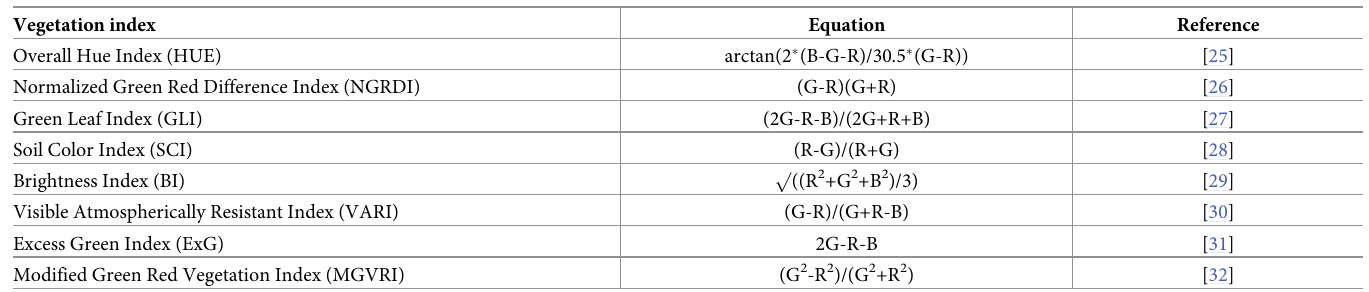
Linear regression models were fit using the percentage split option, where 90% of the dataset was considered for model training. The accuracy of fitted models was checked by the root mean squared error (RMSE) (Eq 1), and the normalized RMSE (NRMSE) (Eq 2). ffiffiffiffiffiffiffiffiffiffiffiffiffiffiffiffiffiffiffiffiffiffiffiffiffiffiffiffiffi P n RMSE ¼